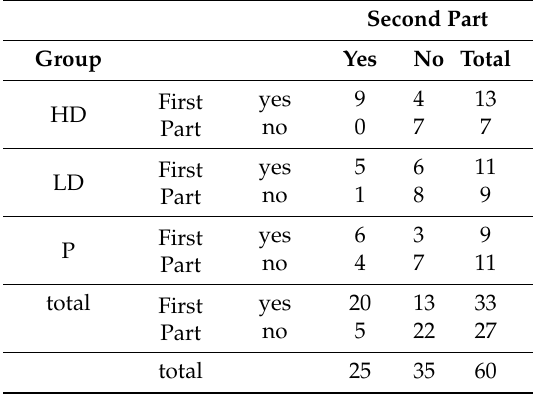
Table 4. Crosstab “sweaty paws” in the examination